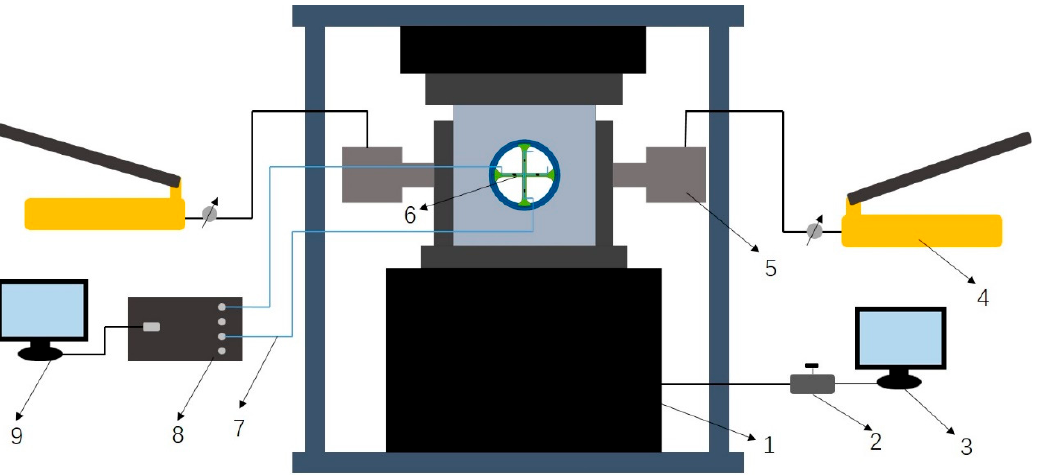
Figure 7. Experimental system diagram. The test system was a combination of many devices, as follows: 1, servo-controlled hydraulic machine; 2, valve; 3, servo-hydraulic machine control system; 4, hydraulic manual pump; 5, jack; 6, fiber Bragg grating sensor; 7, optical fiber; 8, SM130; 9, ENLIGHT System.